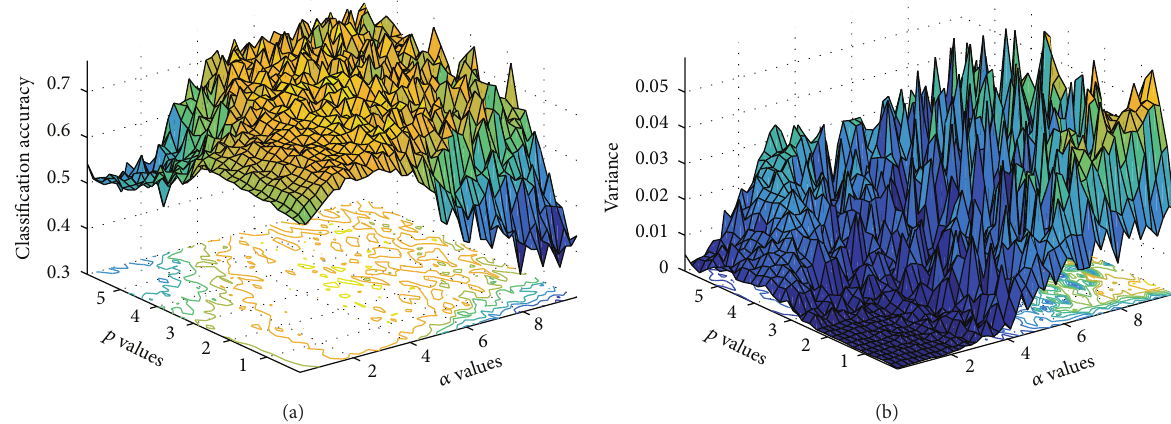
Figure 2: Mean classification accuracies (a) and the variances of the accuracies (b) obtained from the blood transfusion service center data set with the Bonferroni-OWA based similarity classifier with the basic linguistic quantifier variant.